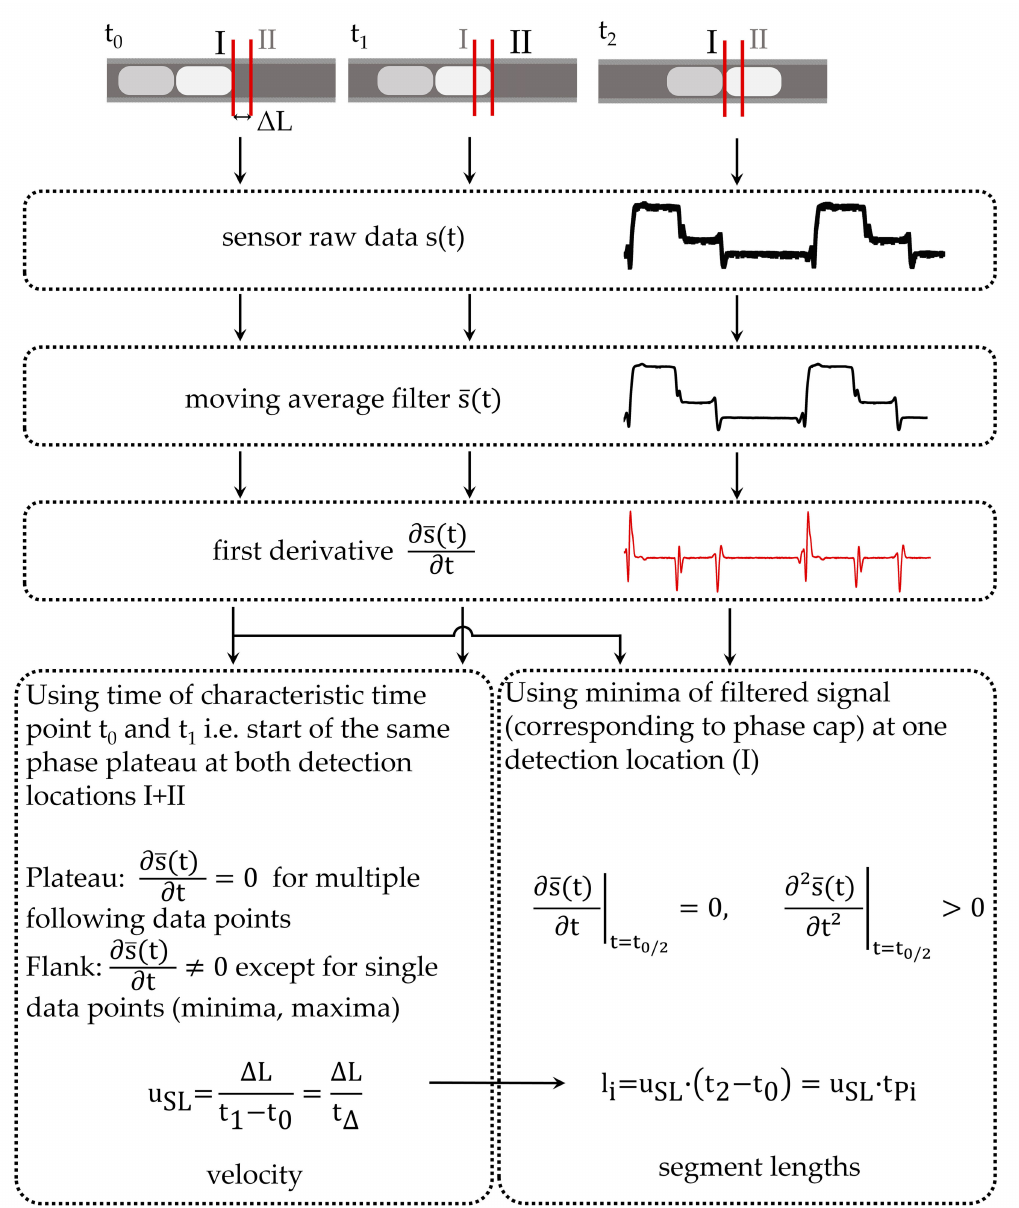
Figure 12. Mathematical approach to determine the velocity in a fully developed slug flow and the length of each phase segment. The velocity is determined by the characteristic time, and a new phase plateau can be seen to begin using the first derivative of the filtered signal. For calculating all segment lengths, the minimum points surrounding the corresponding phase plateau are